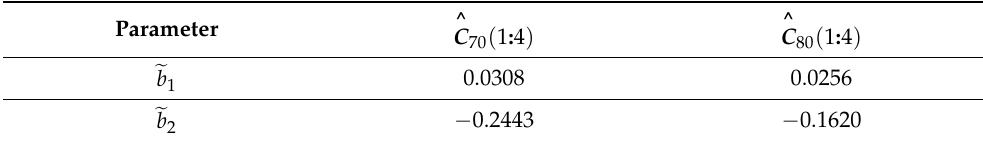
The parameter values in P c , P c , and P c were modeled with a polynomial equa- 2 3 1 tion of order n = 4 (for modeling five points). The models and statistics are shown in Table 24. The calculated parameters’ values (with models in Table 24 at X 2 values) used